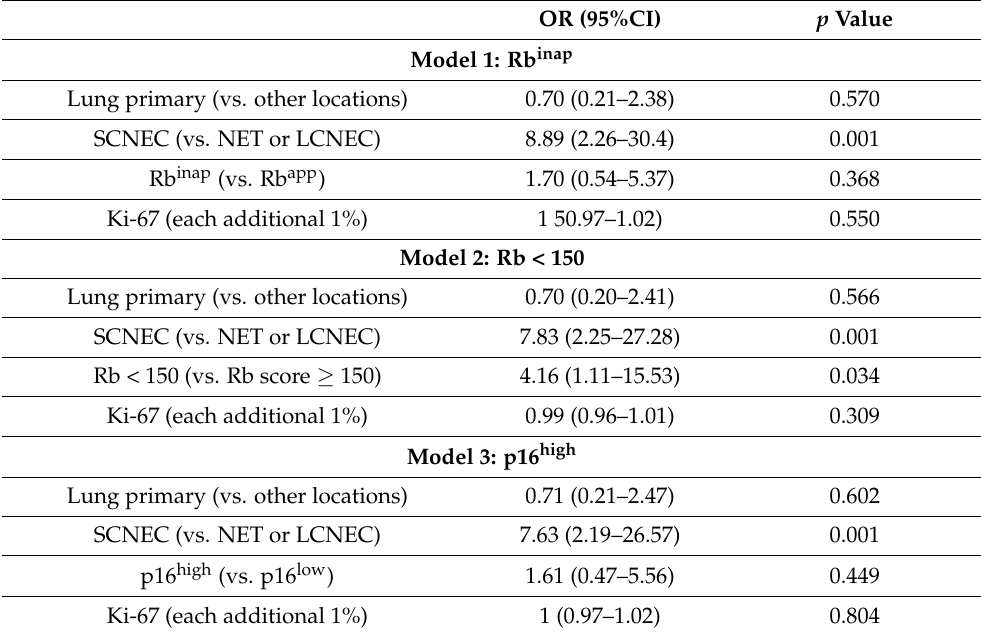
Table 2. Multivariate analysis of factors associated with objective response.